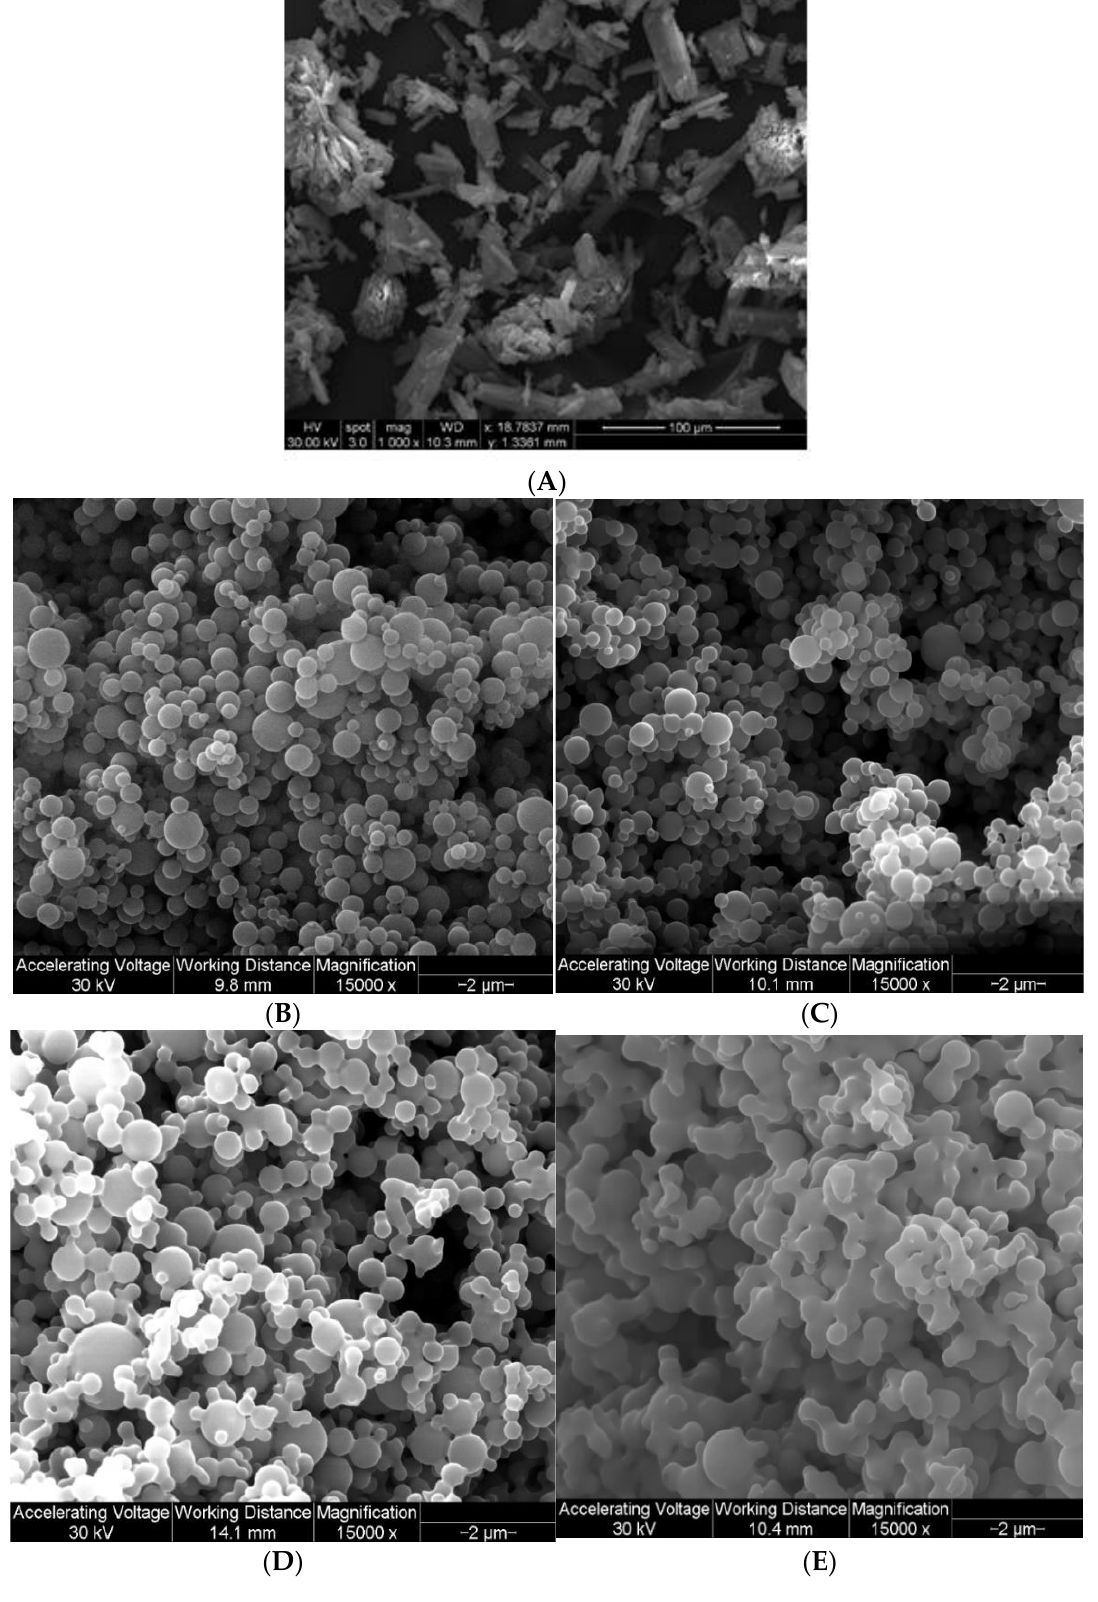
Figure 2. SEM micrographs of: ( A ). raw FAS; ( B ). SD FAS 25% PR; ( C ). SD FAS 50% PR; ( D ). SD FAS 75% PR; and ( E ). SD 100% PR.